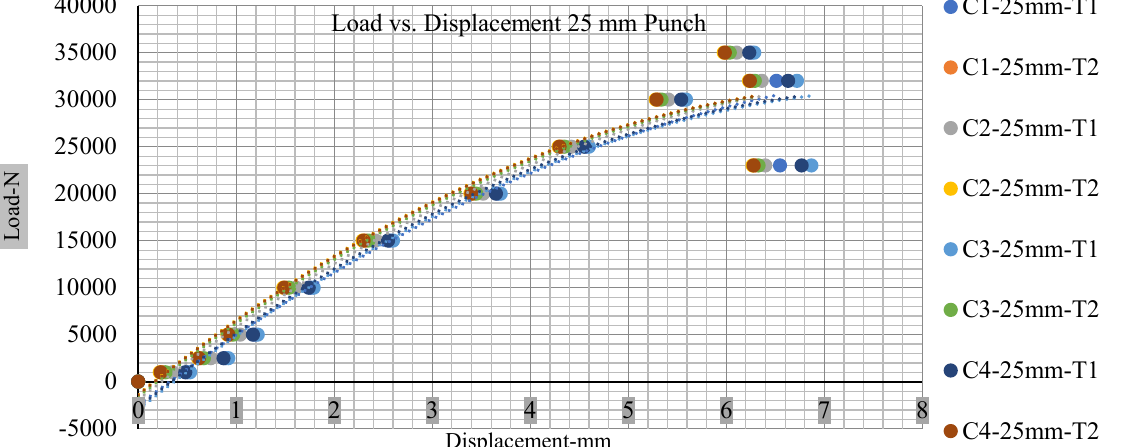
Figure 14. Load vs. displacement 12 mm low to peak loads.